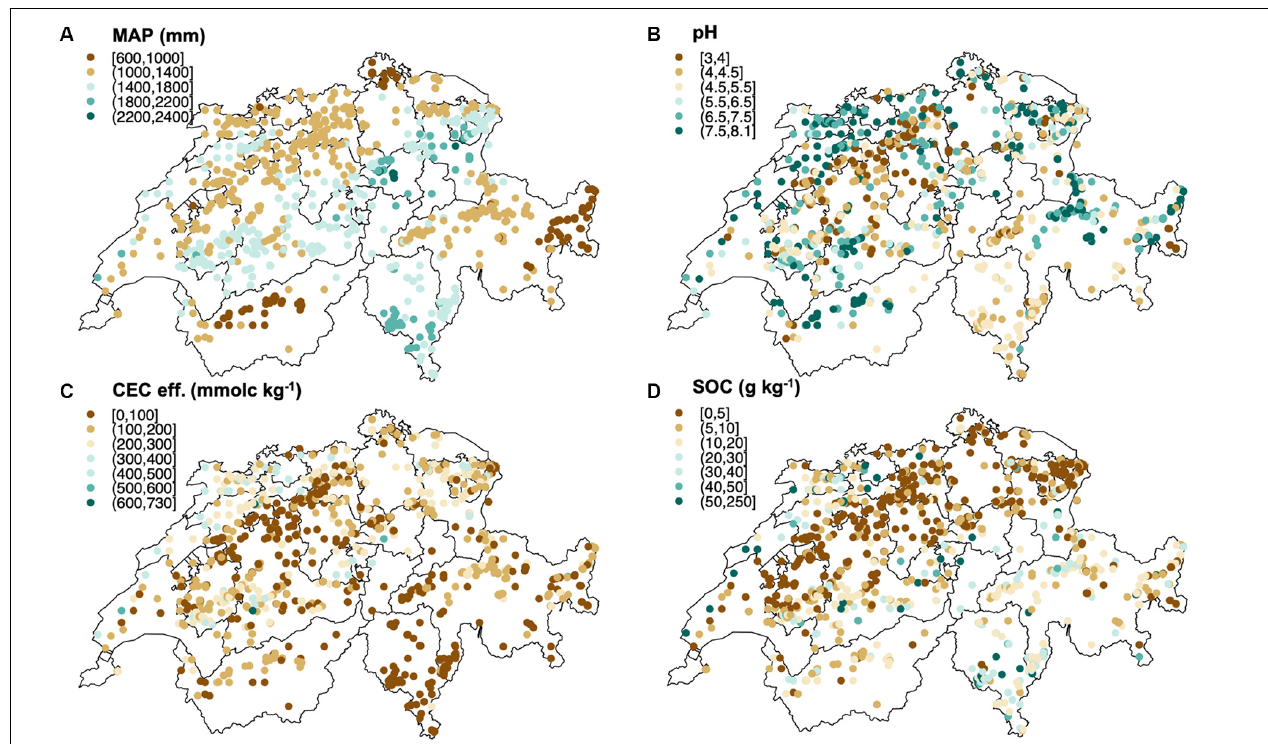
FIGURE 1 | Spatial distribution of (A) mean annual precipitation (MAP), (B) subsoil (30–120 cm depth) pH, (C) subsoil effective cation exchange capacity (CEC eff.), (D) subsoil soil organic carbon (SOC) in the Swiss forest sites analyzed in this study. Maps were built using R packages (“sp,” “lattice,” “RColorBrewer,” “proj4, rworldmap,” “raster,”